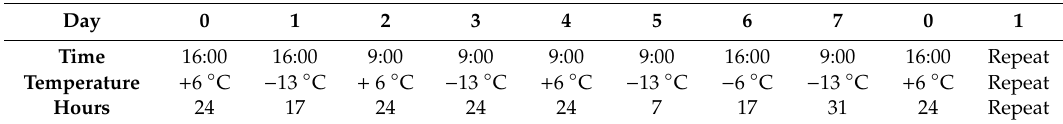
Table 3. Description of temperature changes in the cold chamber of the Hot Box during the unsteady-state